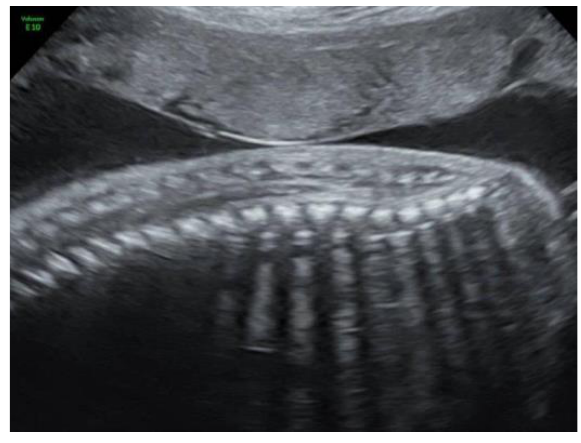
Figure 3. Inconspicuous aspect of the spine at 24 weeks.